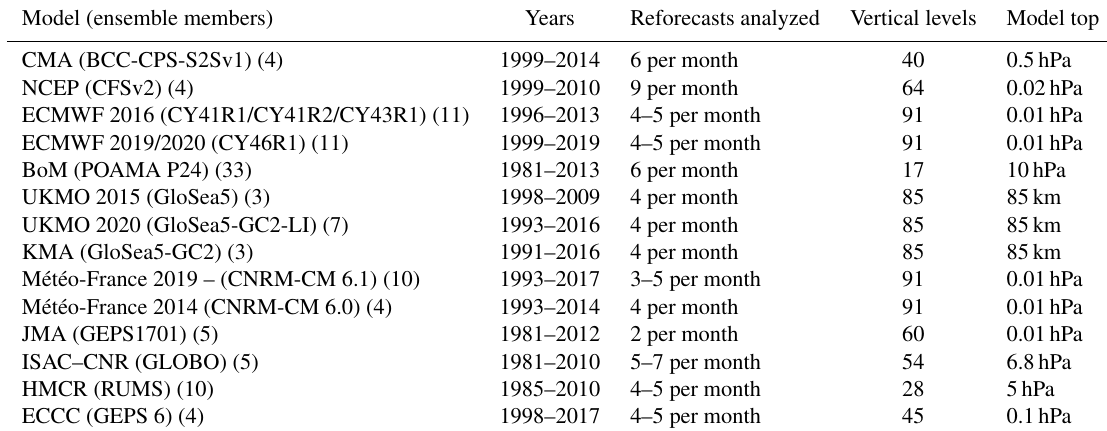
Table 1. S2S model experiments chosen.